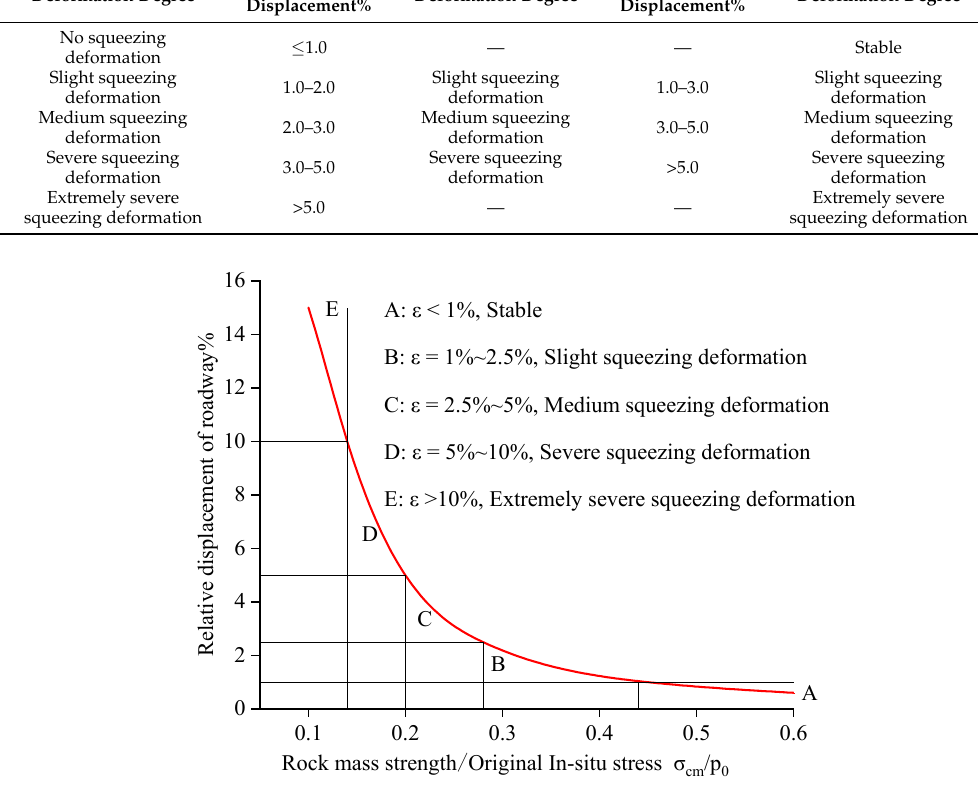
Figure 4. Schematic diagram of surrounding rock deformation class determination [48–51].